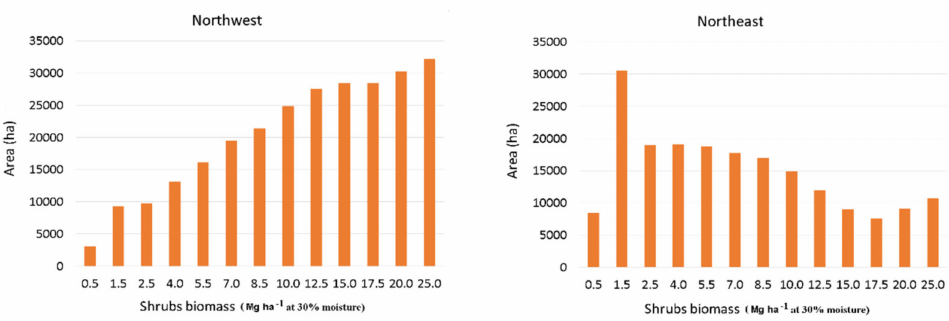
Figure 10. Accumulated shrubs biomass in summer